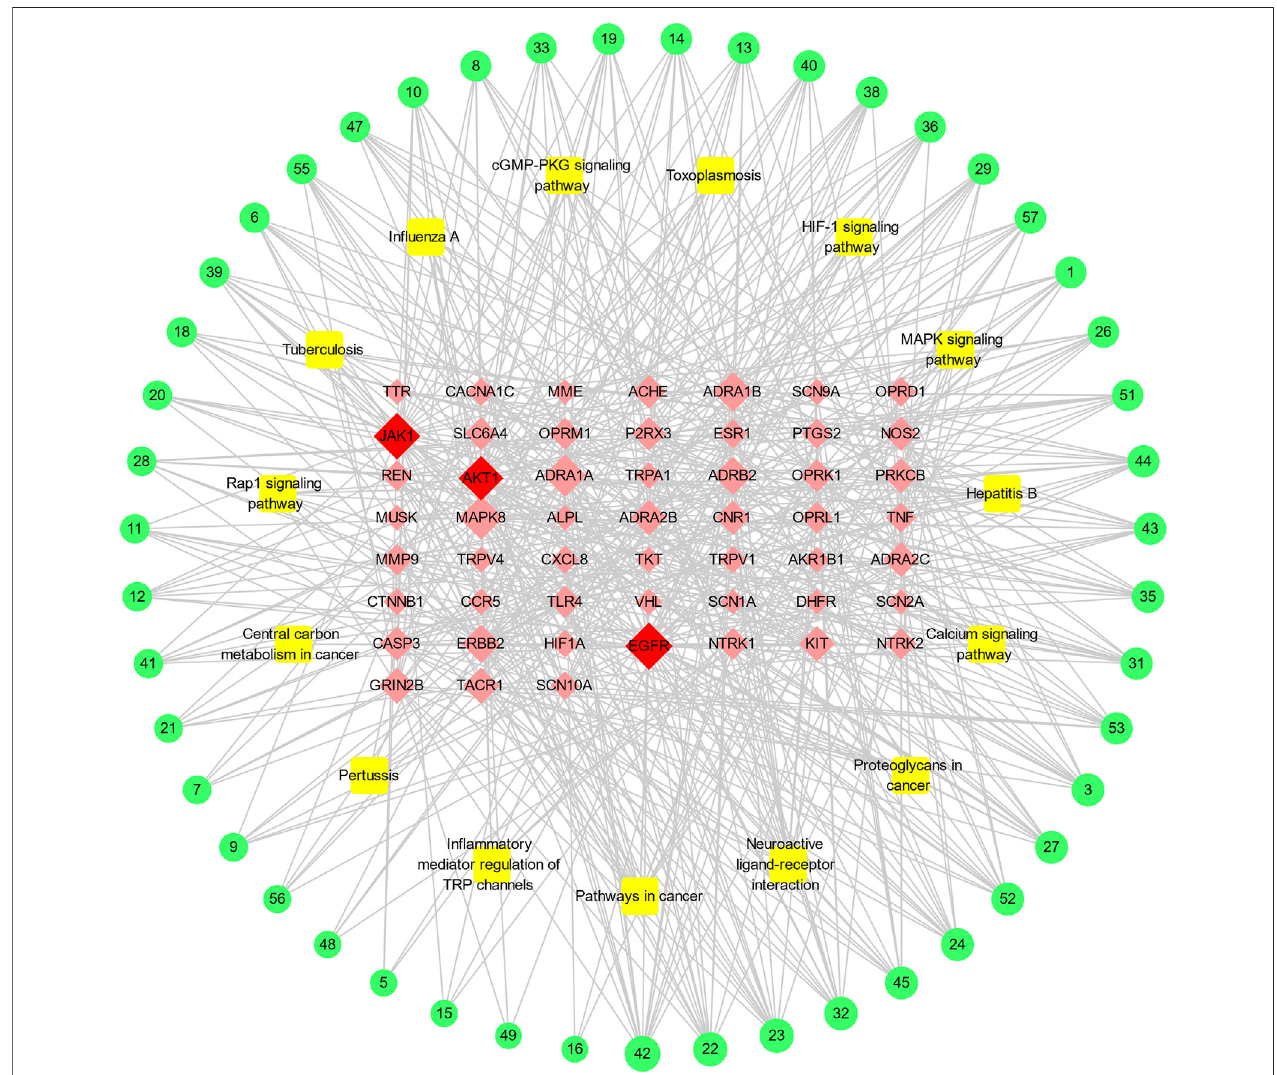
FIGURE 5 | The “ ingredient-target-pathway ” network for GEB in treatment for NPP. The outer green circle represents active ingredient in GEB, the yellow square indicates the potential pathways, and the red diamond stands for the potential target. For corresponding active ingredient names, refer to Supplementary Table1. the potentialtargetgenessharedbyGEBandNPP,theorangetrianglestandsfortheactiveingredientinGEB,andthegreendiamondindicatesthepotentialpathways.The size of the node represents the degree values.